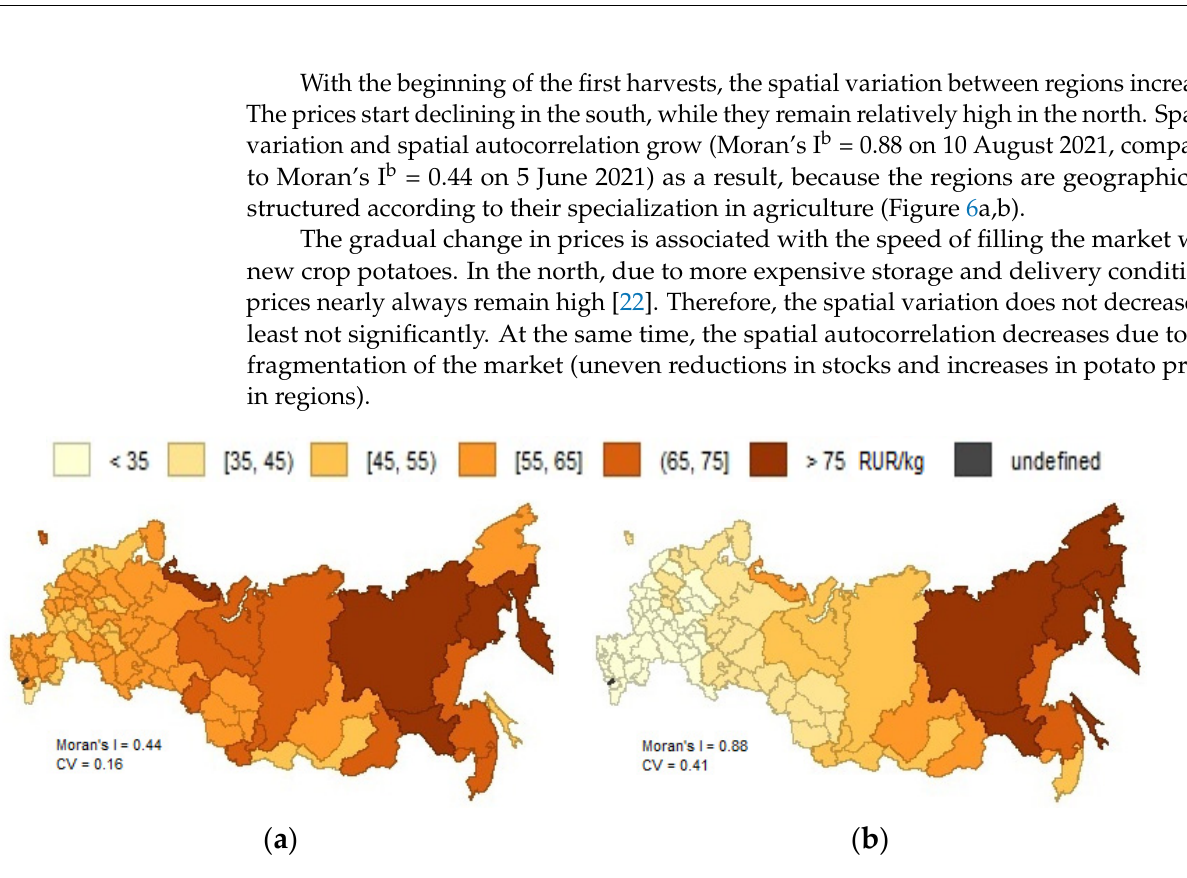
Figure 6. Spatial price of Potatoes price, 5 June 2021 ( a ), 10 August 2021 ( b ). All regions, for which the data are not available for these dates, are marked as “undefined”.